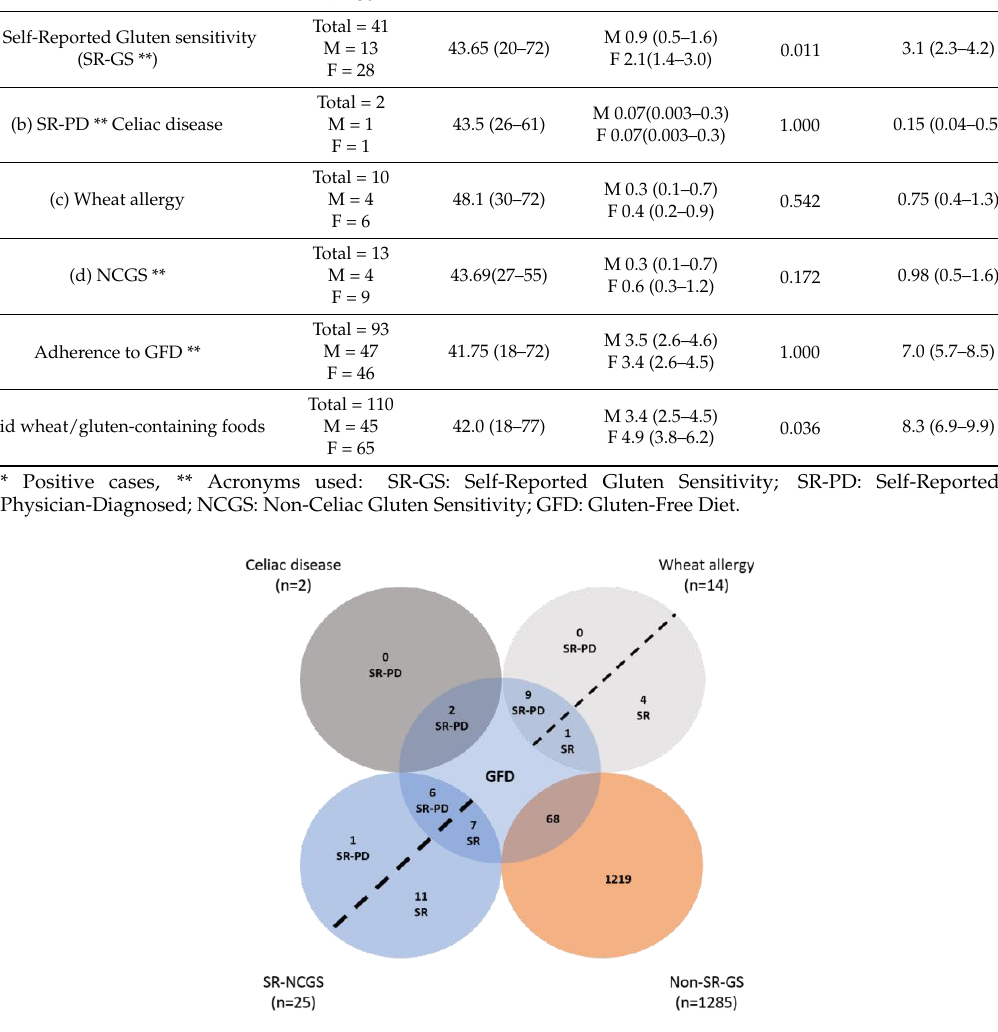
Figure 2. Gluten-free diet (GFD) adherence and avoiding of wheat/gluten according to age. ** p < 0.01 3.3. Cases with More than One Physician-Diagnosed Gluten-Related Disorder Seven respondents reported the coexistence of NCGS, either with CD or WA, or with both conditions. Of these, four cases had to be excluded from the prevalence estimation analysis due to the uncertainty of their diagnoses. The other three cases meet criteria for WA. The characteristics of the cases are shown in Table 3. Table 3. Individuals who reported the coexistence of NCGS with other gluten-related disorders. Individual ID